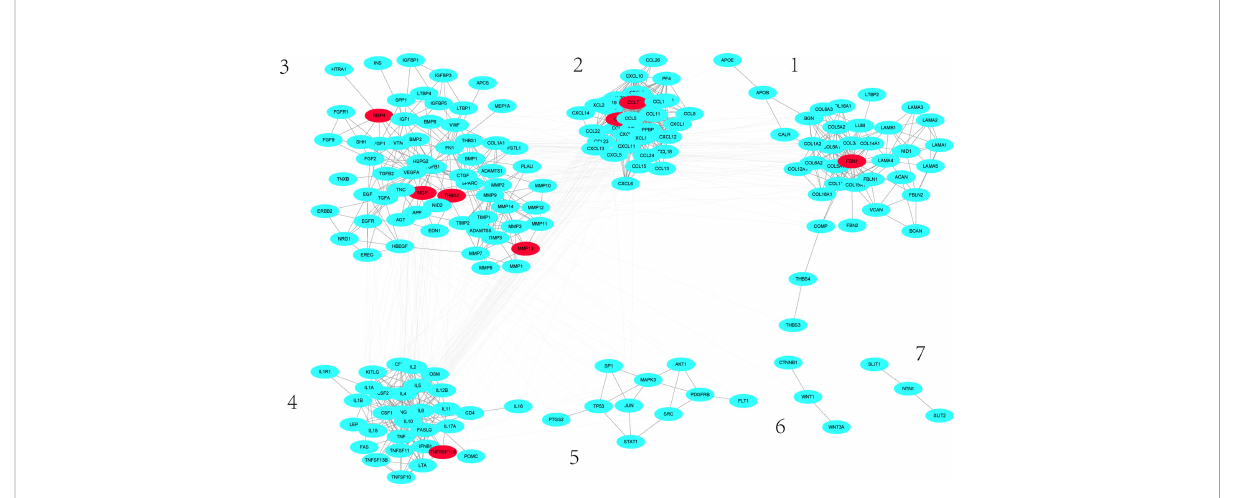
FIGURE 3 Sub-network signi fi cantly in fl uenced by differentially expressed genes. Red nodes denote differentially expressed genes.